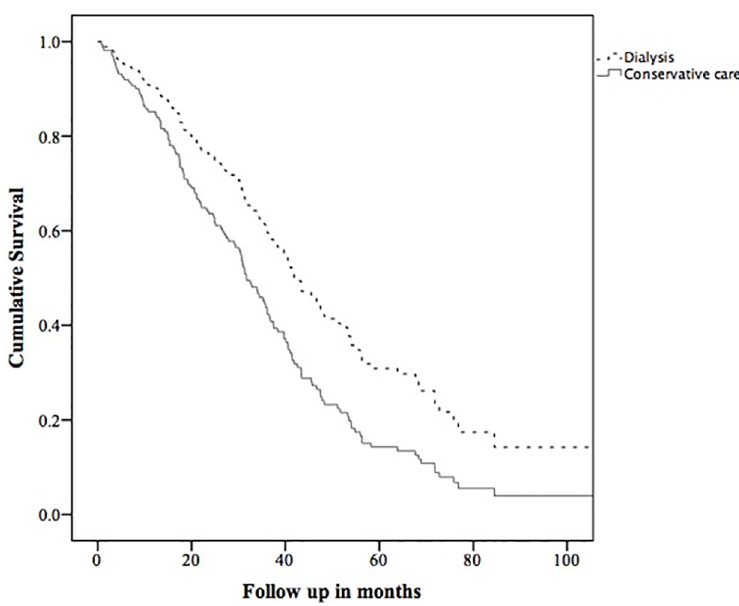
Fig 2. Survival curve comparing dialysis with conservative care from the date of first outpatient eGFR � 15 mL/ min/1.73m 2 . Adjusted for age, peripheral vascular disease, and living alone.